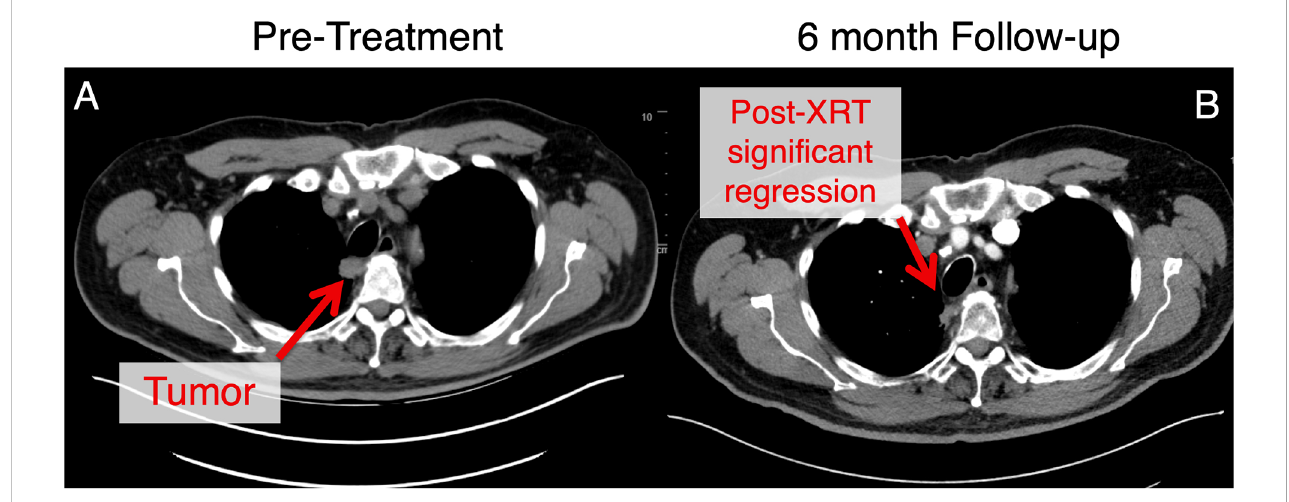
FIGURE 6 This patient with an ultracentral tumor was treated with 60 Gy in 8 fractions with daily adaptive therapy. This tumor was adjacent to the trachea and esophagus at the start of treatment (A) . Follow-up at approximately 6 months (B) , there has been signi fi cant tumor regression for this patient. This patient experienced mild gastroesophageal re fl ux disease at baseline that was managed with proton pump inhibitor therapy without any other toxicities